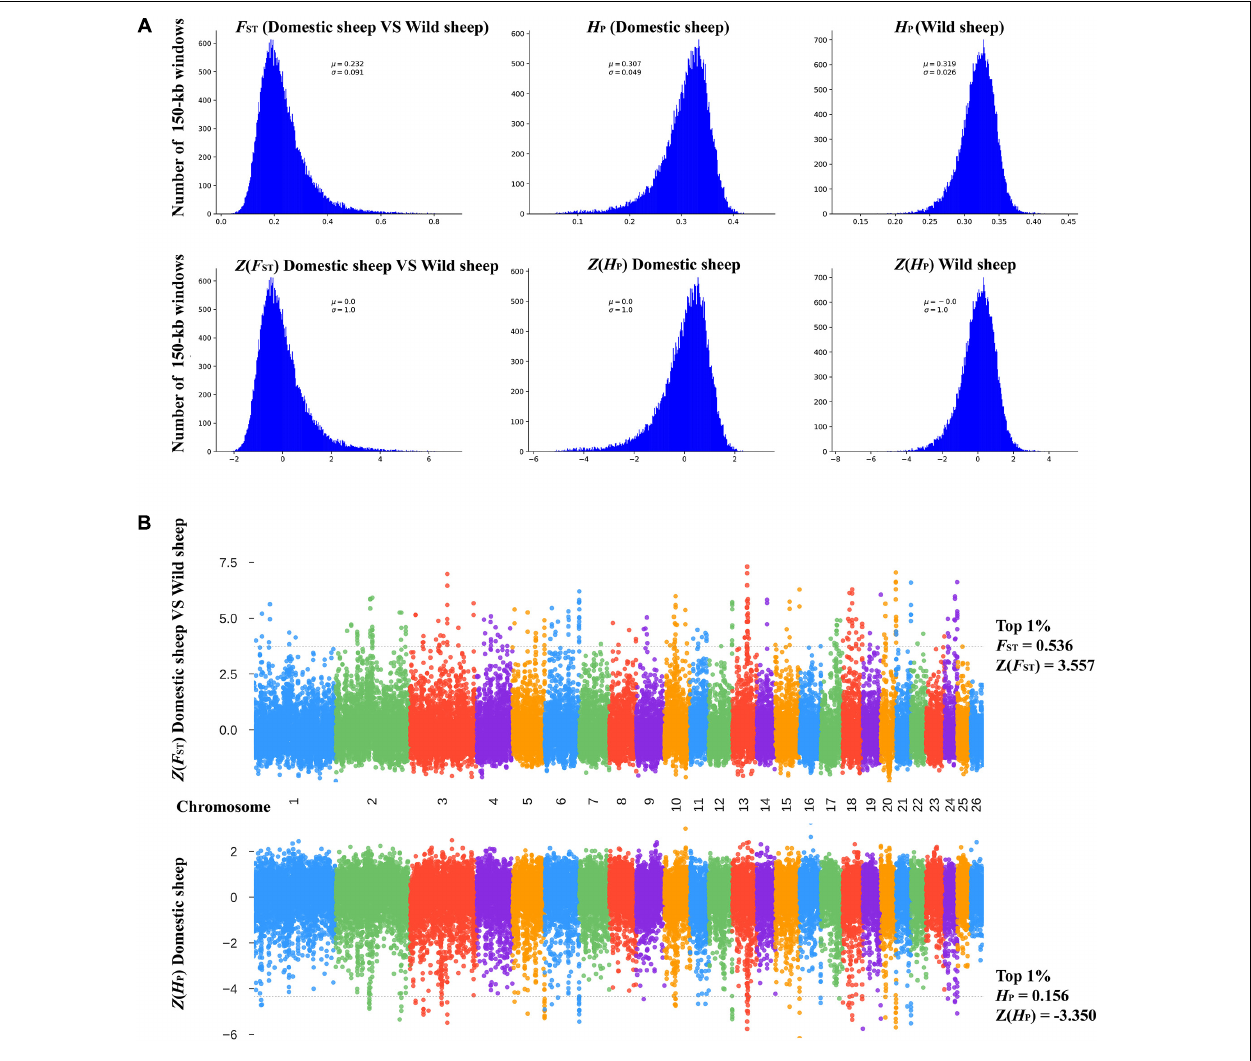
FIGURE 2 | Genome-wide selection analyses identified 98 candidate regions associated with domestication. (A) Distribution of Z-transformed average pooled heterozygosity in domestic sheep [ H P ( Domesticsheep ) and Z ( H P ) Domesticsheep ] and Asian Mouflon [ H P ( AsianMouflon ) and Z ( H P ) AsianMouflon ] as well as average fixation index [ F ST ( Domesticsheepvs . AsianMouflon ) and Z( F ST ) Domesticsheepvs . AsianMouflon ] values for 150-kb windows ( σ , standard deviation; µ , average). (B) Plot of the Z(H P ) and Z(F ST ) values for domestic sheep along the sheep genome. A dotted line indicates the cut-off [ Z(H P ) ≤ –3.350 and Z(F ST ) ≥ 3.557] used for extracting outliers.